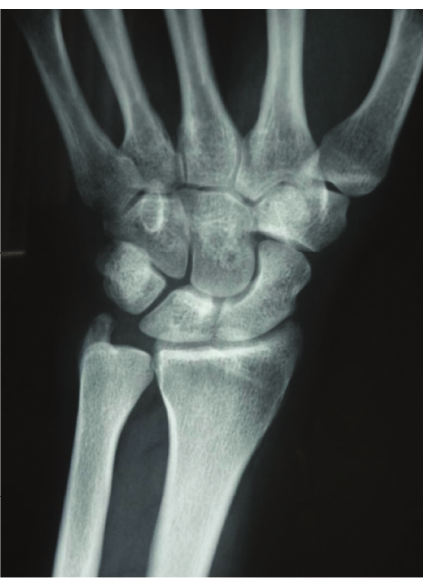
Figure 1: Visualization of lytic lesion of 0.4 mm diameter with a sclerotic line surrounding the ulnar styloid apophyses.